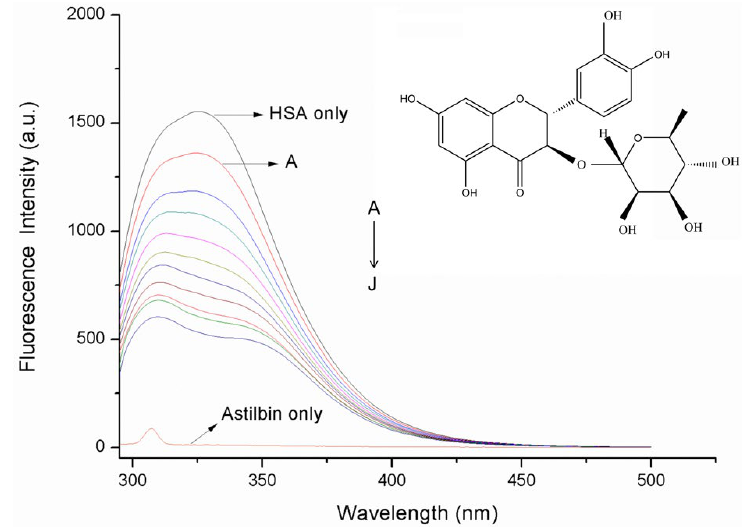
Figure 1. Emission spectra of HSA in the absence and the presence of astilbin, from A to J, C HSA : 2.5 × 10 −6 mol·L −1 , C astilbin (A–J): 2.5, 5, 7.5, 10, 12.5, 15, 17.5, 20, 22.5, 25 × 10 −6 mol·L −1 , T = 298 K , λ ex = 280 nm, pH = 7.4. The concentration of native astilbin was 2.5 × 10 −6 mol·L −1 .